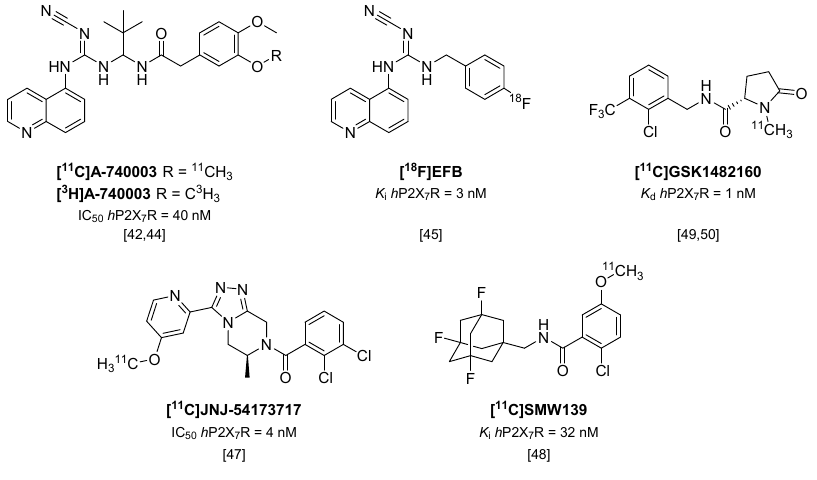
Figure 4. Radiolabeled P2X 7 receptor antagonists.